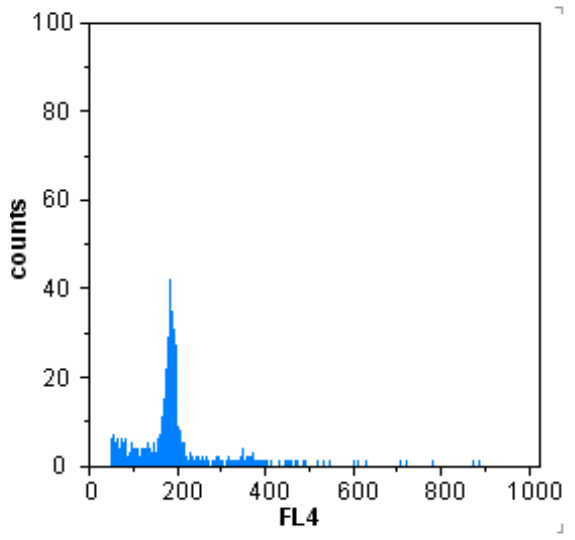
Figure 3. Representative flow cytometric histograms. Relative fluorescence intensity (FL4) obtained after simultaneous analysis of nuclei isolated from leaves of pyrethrum mother plant and micro- propagated plants.